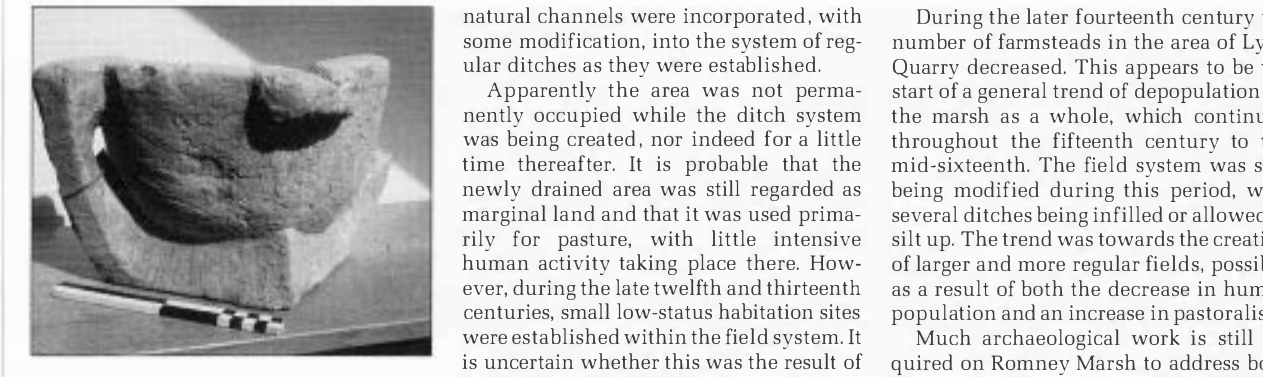
A medieval (thirteenth to four­ teenth century) limestone mortar exca­ vated at Lydd 6. It is likely to have come from near Folkestone (scale bar 20cm). the pottery and the stone artefacts (Fig. 5), the trade network associated with all the occupation sites appears to have been directed primarily towards the east. Most trade goods probably reached the settle­ ments via the port of New Romney, some 5 km to the northeast, because land passage across the marsh is likely to have been slow and difficult, particularly in winter. Mate­ rial from farther afield, such as grinds tones (querns) made of volcanic lava from Ger­ many, and pottery from France and Scar­ borough in Yorkshire, are also likely to have come via New